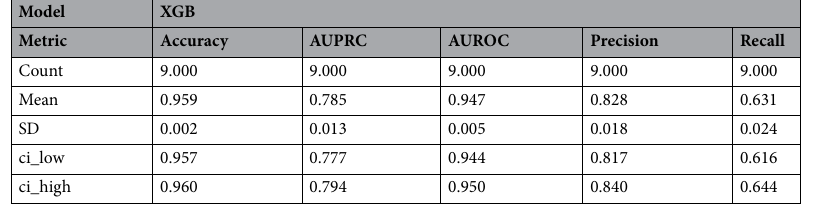
Table 2. Model performance of the developed model. The values are derived from 9 iterations, which is the number of fold (k = 3) * the number of epochs (N = 3). Final performance value is the average of three-fold validation over three cohorts. The confidence interval is calculated by bootstrapping first then calculating the 95 percentile range. ci_low Lowest 95% confidence interval of experiments, ci_high Highest 95% confidence interval of experiments, SD Standard Deviation, AUPRC Area Under Precision-Recall Curve, AUROC Area Under Receiver-Operator